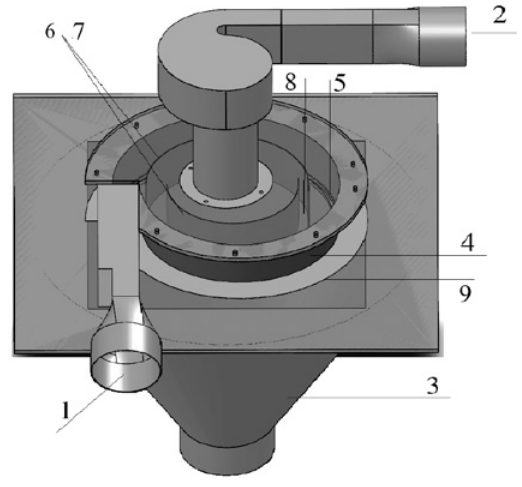
Fig. 1. Experimental spiral multichannel cyclone separator: contaminated solid particles in the air flow inlet (1); purified air outlet (2); conical hopper (3); spiral-shaped separation chamber (4) with sectional ring slits (5); curved channels (6) with cylindrical half-rings of different radius (7), spacing between the curved channels (8); spiral casing of the cyclone separator well (9)